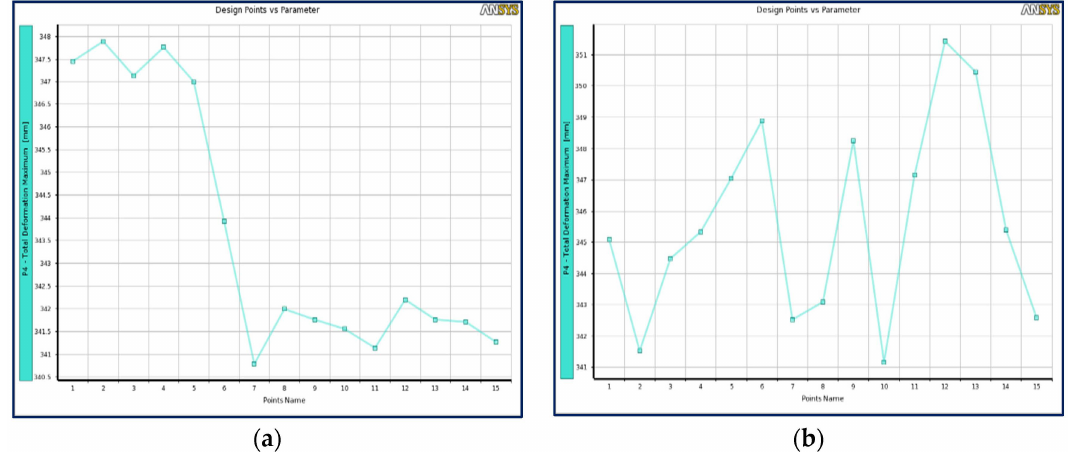
Figure 15. Total deformation vs. design points ( a ) for CCD scheme, and ( b ) OSF